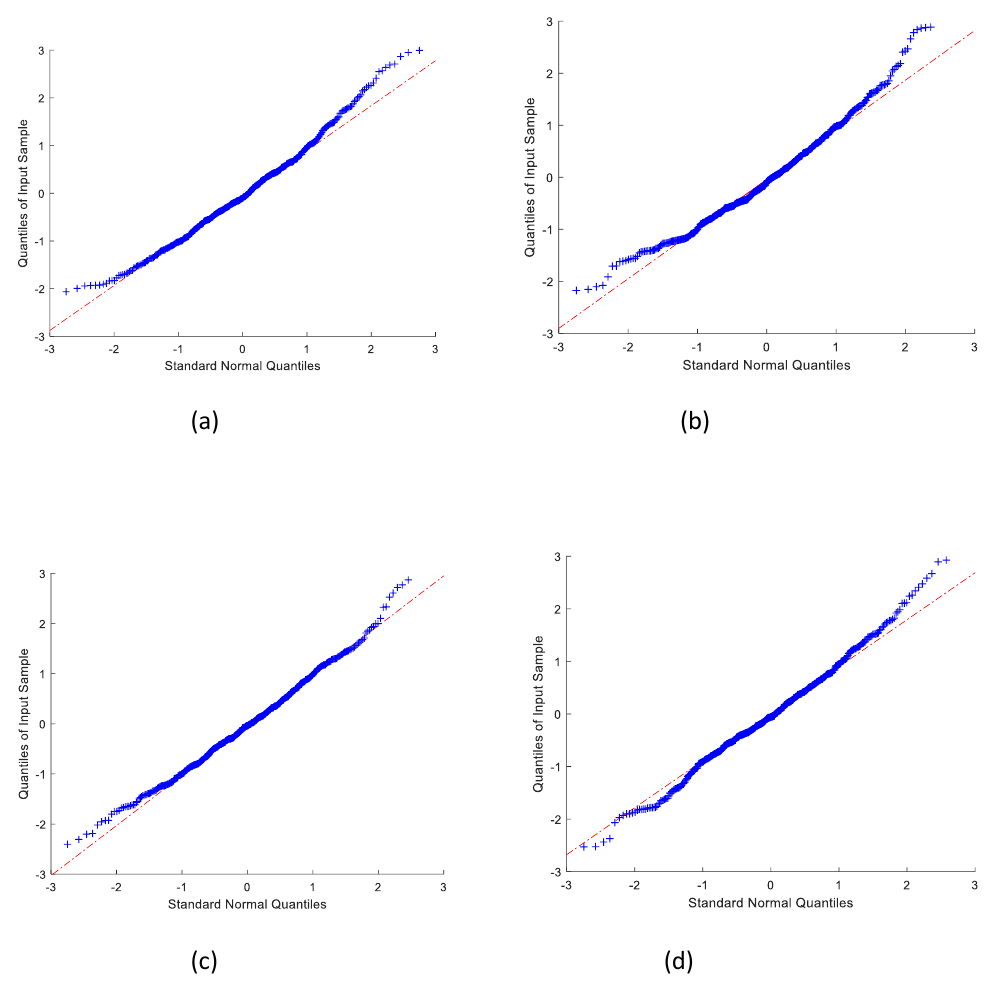
11 of 16 Figure 2: QQ plot of estimated coefficient on 𝒔/𝟏𝟎𝟎